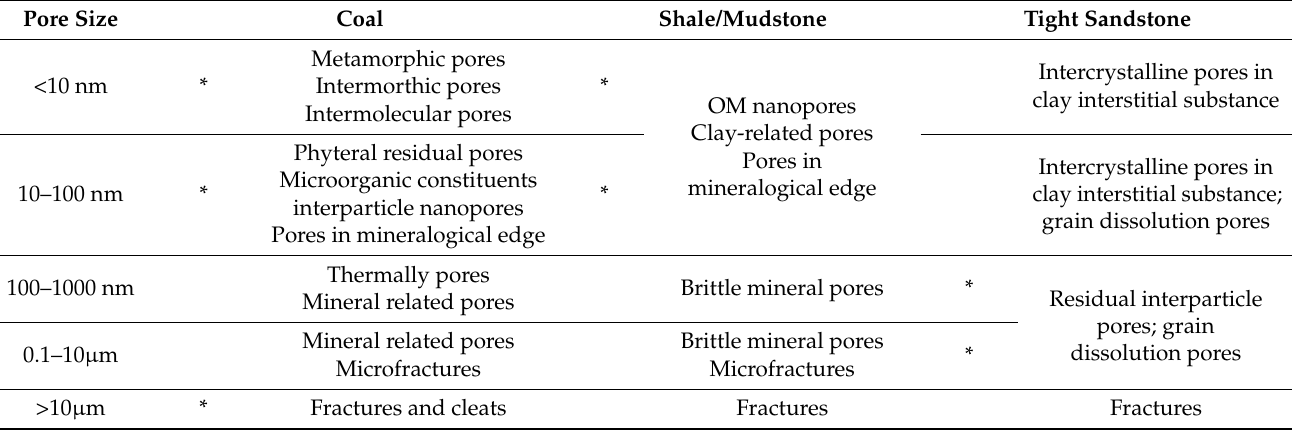
Table 5. The systematic classification and comparison of reservoir space of high-rank coal, shale, and tight reservoirs at nanoscale to fracture